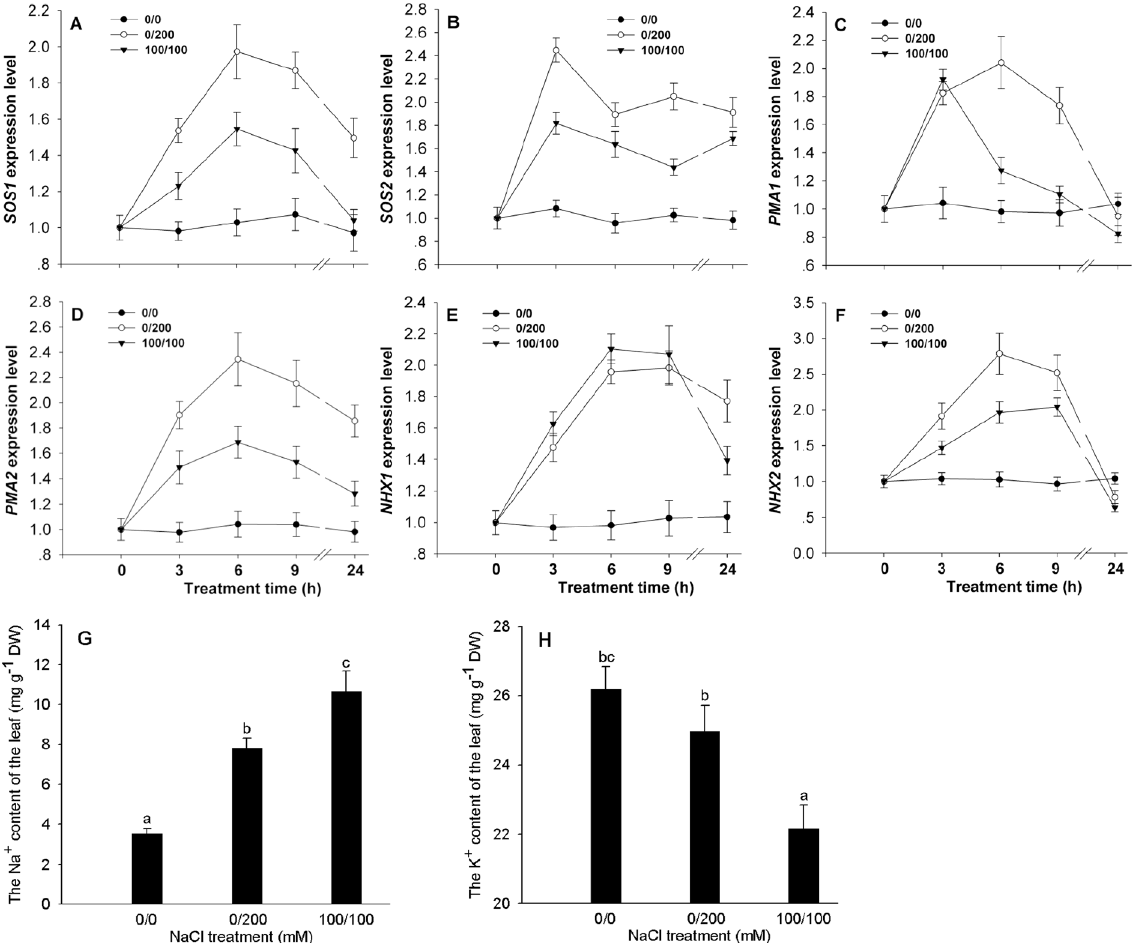
Figure 3. The expression patterns of SOS1 ( A ), SOS2 ( B ), PMA1 ( C ), PMA2 ( D ), NHX1 ( E ) and NHX2 ( F ) in leaves under uniform (100/100 mM NaCl) and non-uniform (0/200 mM NaCl) salinity treatments and Na + ( G ) and K + ( H ) contents in leaves at 1 day after salinity treatments. Data are means of six biological replicates ( ± SD). Different letters indicate a significant difference ( P < 0.05) within each